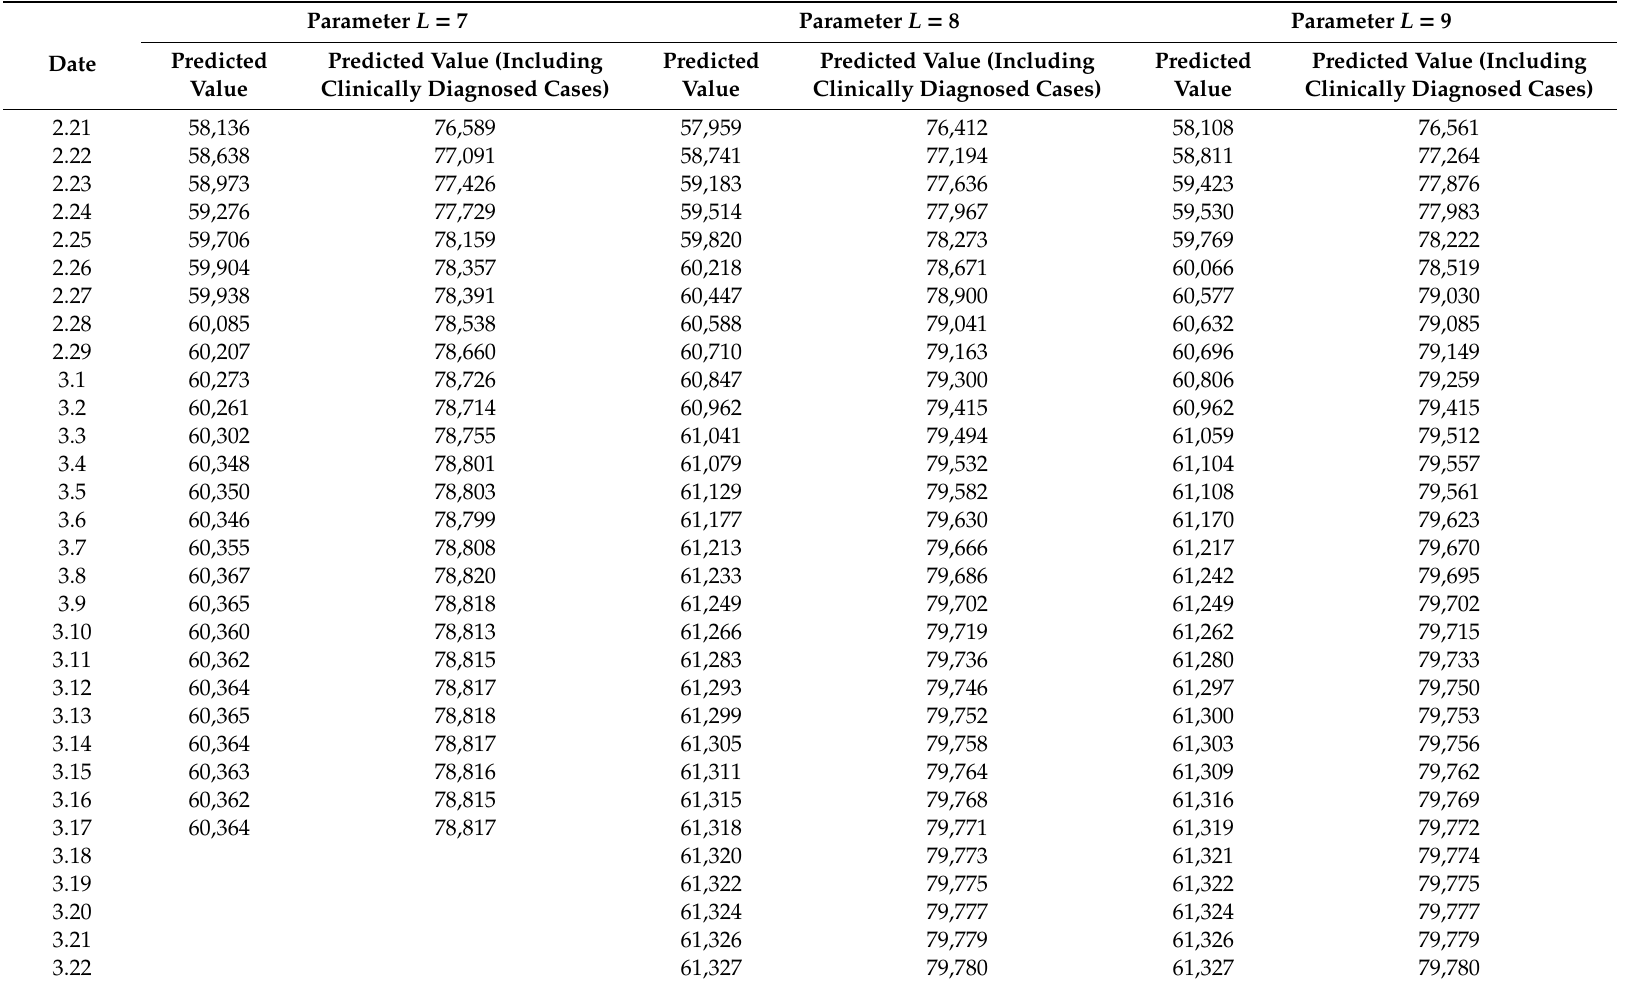
Table 5. The distributions of predicted